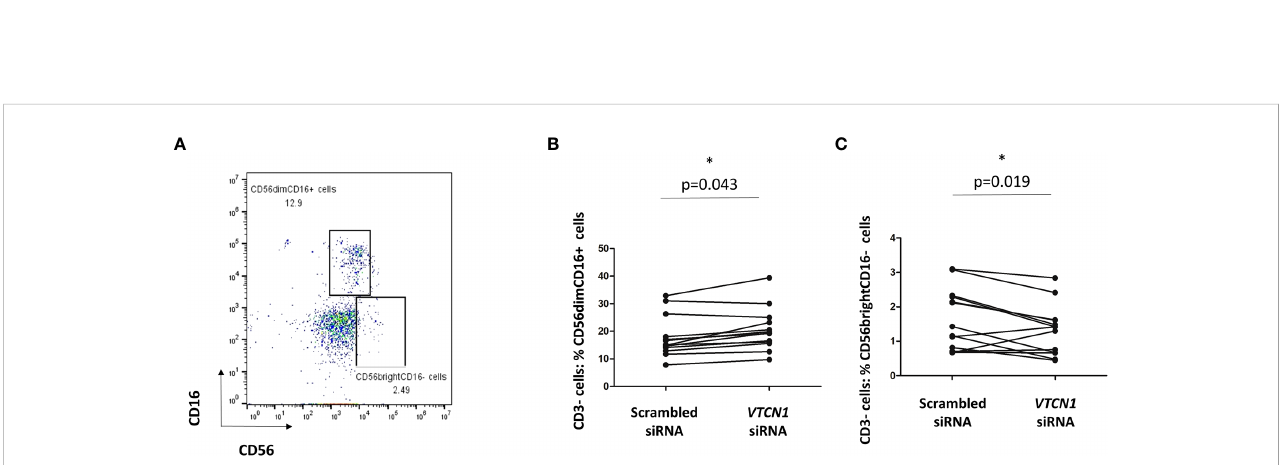
FIGURE 7 (A) PBMCs isolated from pregnant volunteers were co-cultured with TB cells with or without VTCN1 KD from BAP d5 to d8 (KD d2-d5). Flow cytometry was used to analyze the CD56 and CD16 expression on CD3- lymphocytes in co-culture. (B, C) Flow cytometry was used to analyze the effects of VTCN1 KD in TB cells on human CD3- CD16+ CD56dim cells (B) and CD3- CD16- CD56bright (C) peripheral blood cells after coculture with TB cells. Results are expressed as percentages. p-values were calculated using the paired t-test (n=13); signi fi cant differences are indicated by